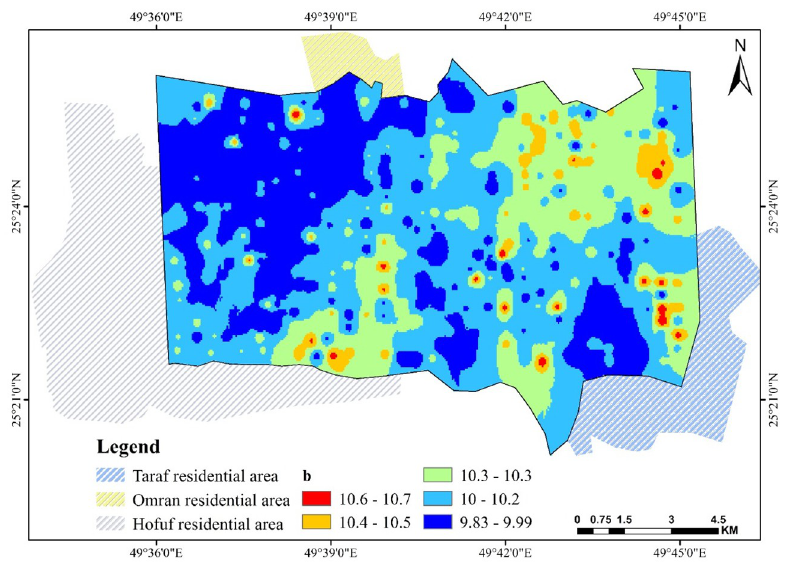
Fig 9. Spatial pattern of b over